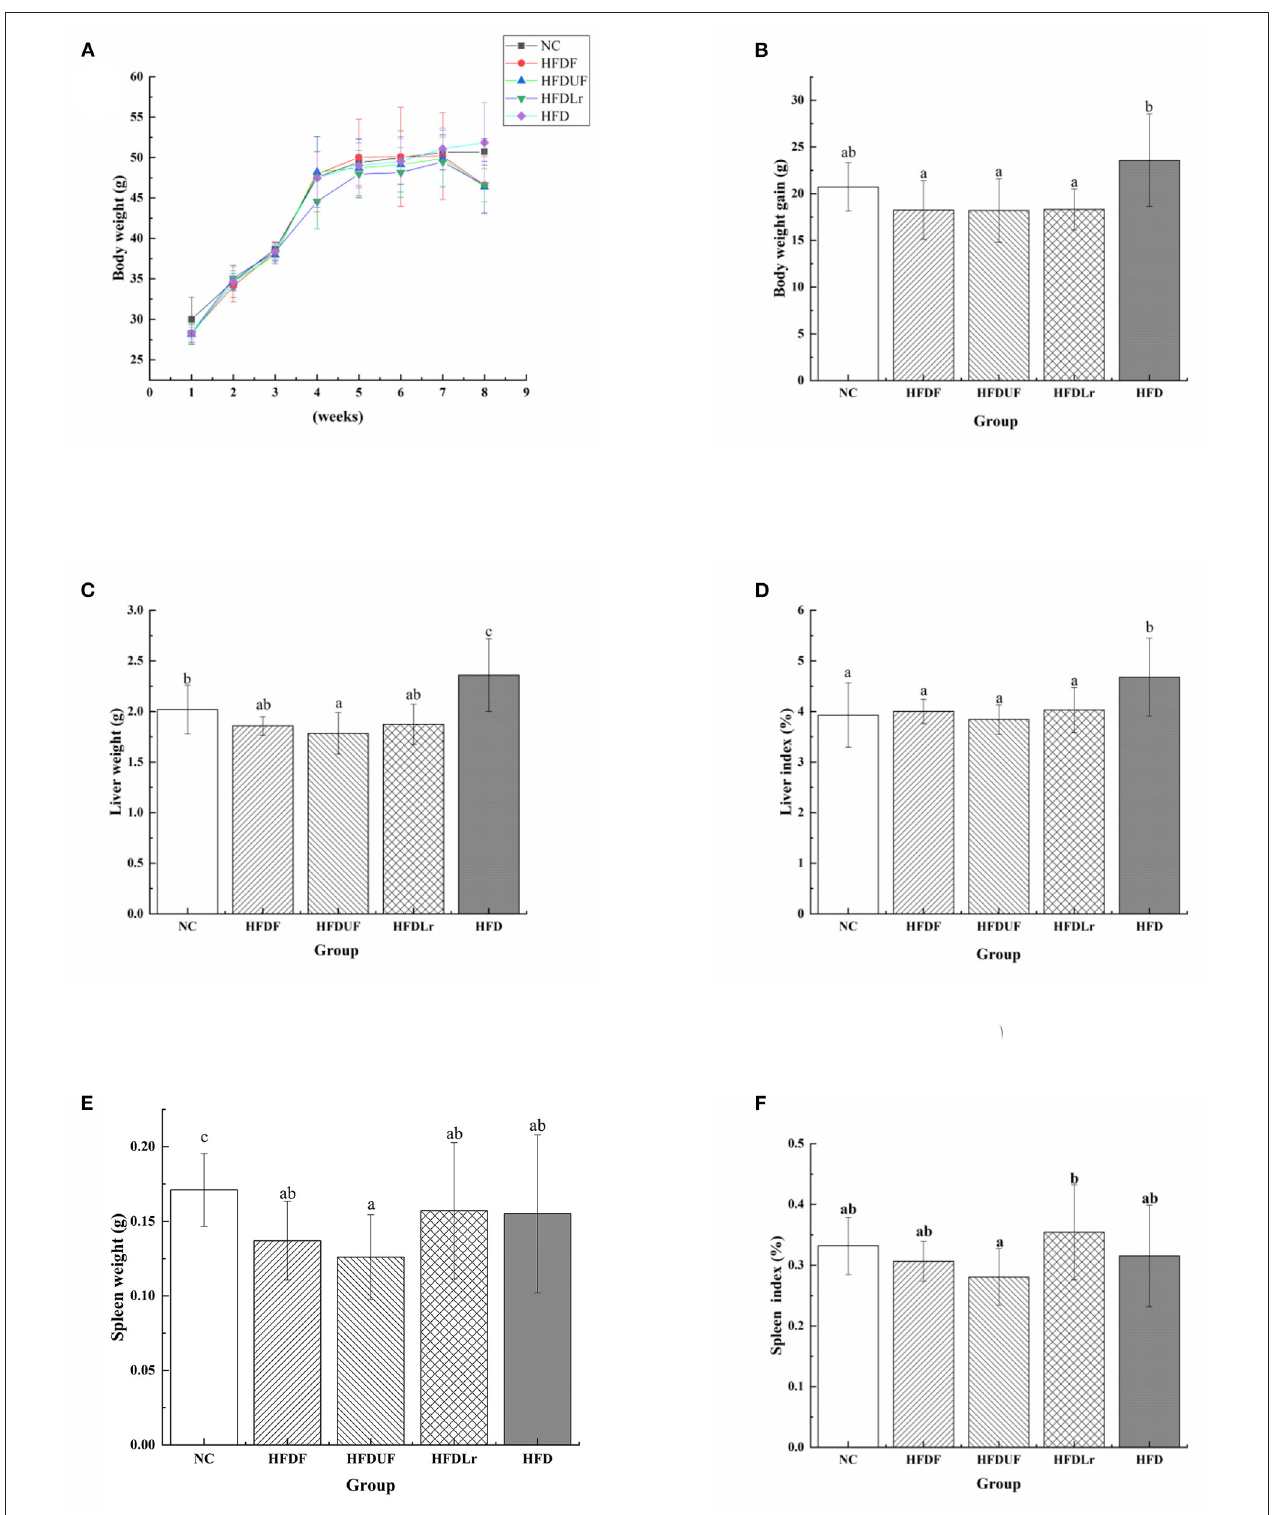
FIGURE 1 | The effects of CSM on body weight and viscera index of HFD-fed mice. (A) Body weight, (B) body weight gain during the experiment, (C) liver weight, (D) liver index, (E) spleen weight, (F) spleen index. All data are expressed as the mean ± SD (n = 10 mice/ group). The statistical differences between groups were analyzed using ANOVA. A p value < 0.05 was considered statistically significant. The superscript letters indicate significant differences between groups.